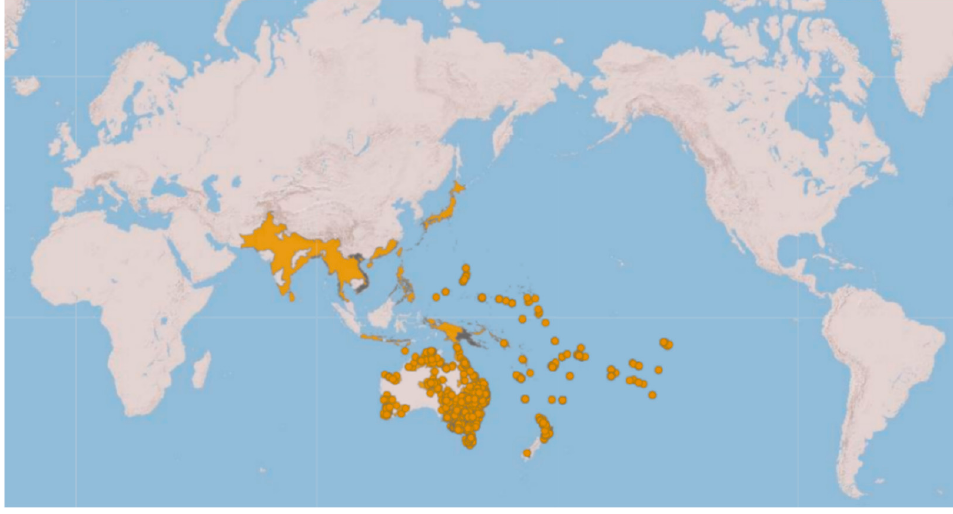
Figure 1. Map showing the geographic distribution of Ischnura aurora (orange dots). Modified from Dow et al. [22].